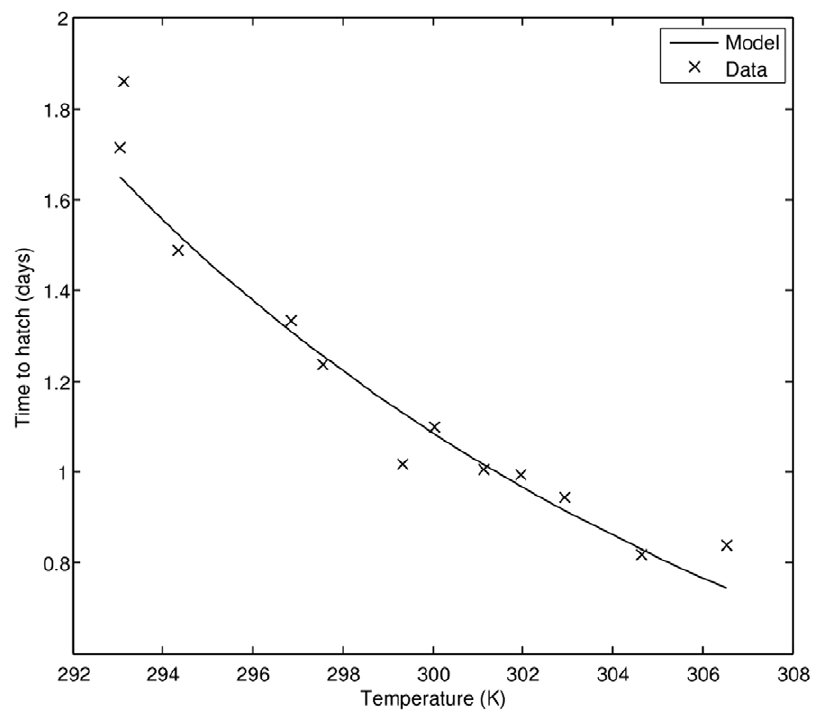
Figure 2. Time to hatching as a function of seawater temperature; comparison of model results to observations (data source: [ 28 ] ).